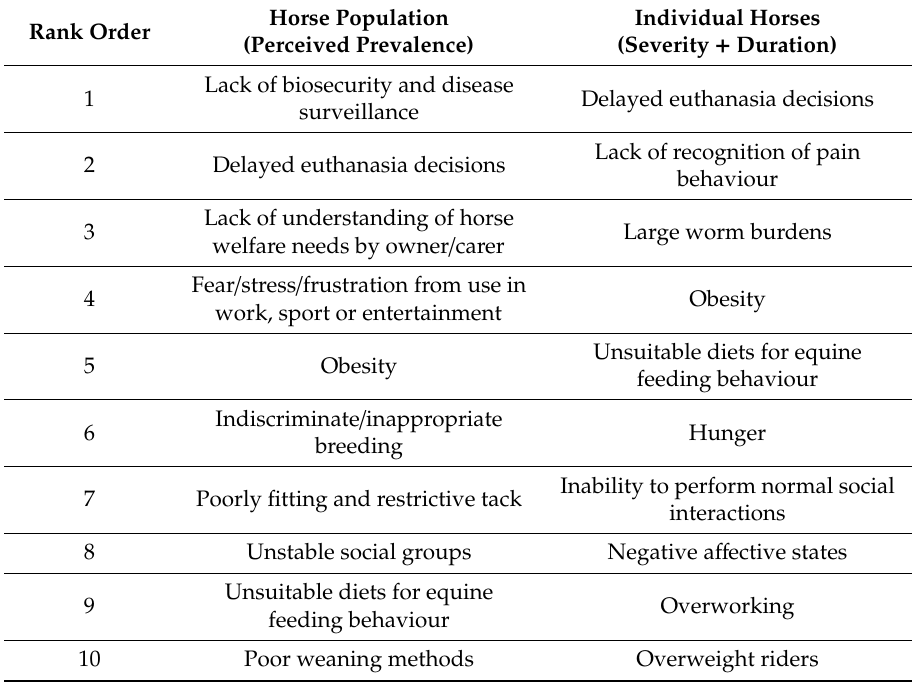
Table 3. Ranked prioritized welfare issues for horses derived from the workshop for individual horses (combined severity and duration of the welfare issue in the experts’ opinion) and for the UK horse population (perceived